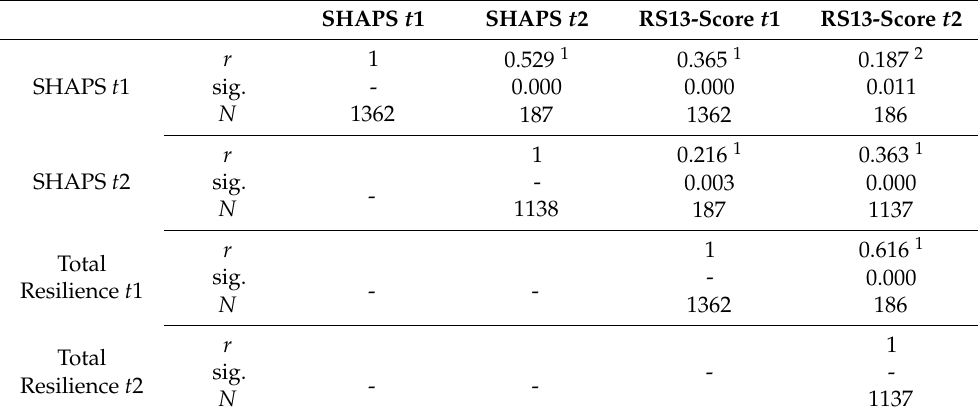
Table 4. Correlations between SHAPS and total resilience at both measurement points.